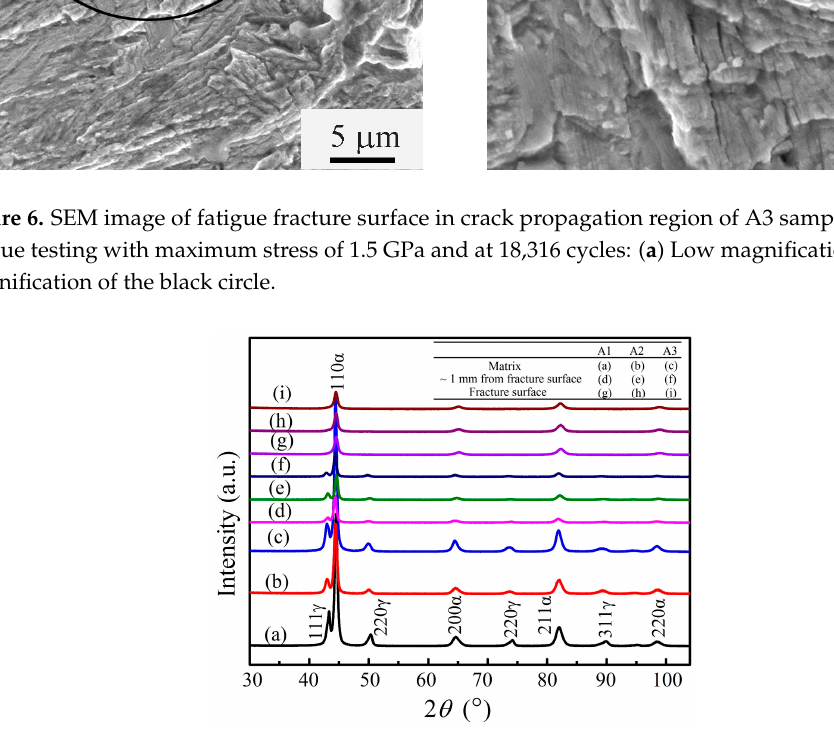
Figure 7. XRD patterns obtained in matrix, fatigue fracture surface and nearby fracture surface of ( A1 ) (1.5 GPa, 8566 cycles); ( A2 ) (1.5 GPa, 10,970 cycles) and ( A3 ) (1.6 GPa, 12,254 cycles) samples. Table 2. VRA in matrix, fracture surface and nearby fracture surface of fatigue fracture samples through XRD (vol %).